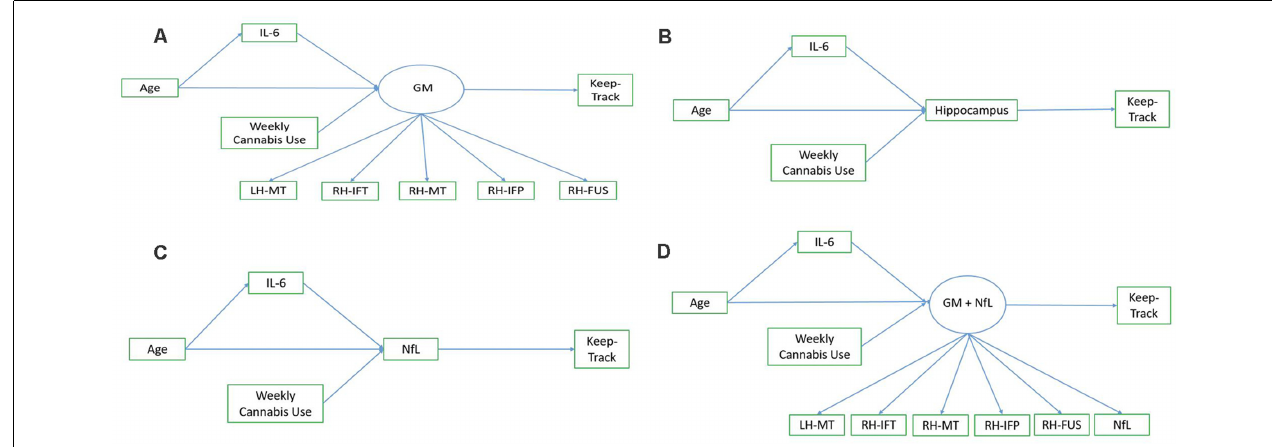
FIGURE 1 | Conceptual models. Panel (A) shows the conceptual model of the relationship between age, IL-6, the frontal gray matter (GM) latent variable, and Keep Track. Panel (B) shows the conceptual model of the relationship between age, IL-6, hippocampal volume, and Keep Track. Panel (C) shows the conceptual model of the relationship between age, IL-6, NfL, and Keep Track. Panel (D) shows the conceptual model of the relationship between age, IL-6, frontal GM/NfL latent variable, and Keep Track. Note. LH-MT, left hemisphere middle temporal thickness; RH-IFT, right hemisphere inferior temporal thickness; RH-MT, right hemisphere middle temporal thickness; RH-IFP, right hemisphere inferior parietal thickness; RH-FUS, right hemisphere fusiform thickness; NfL, Neurofilament light